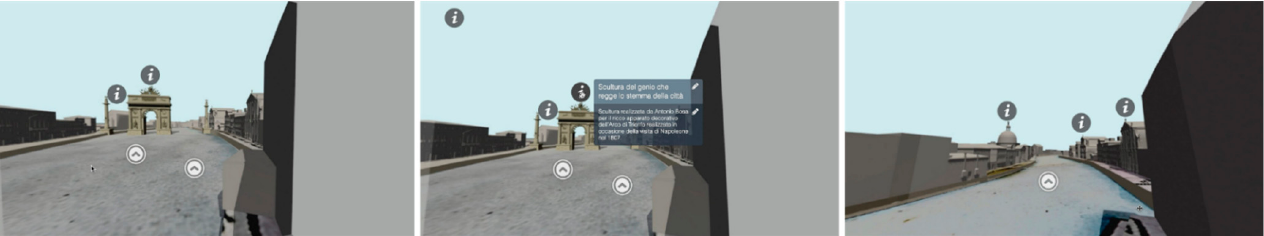
Figure 24. Views of the virtual